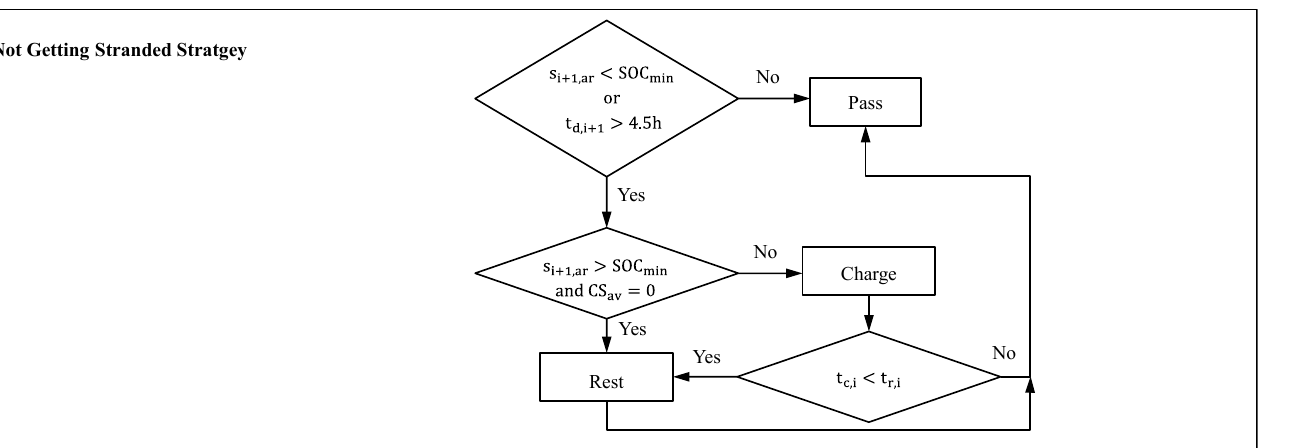
Figure 4. Decision tree of the assumed NGS strategy: If the predicted SoC at the next PoI s i + 1,ar is higher than the minimum SoC min and the predicted total driving time at the next PoI t d,i + 1 is less than 4.5 h, the BET passes the current PoI i . Else the vehicle is charged and/or the driver takes his rest.